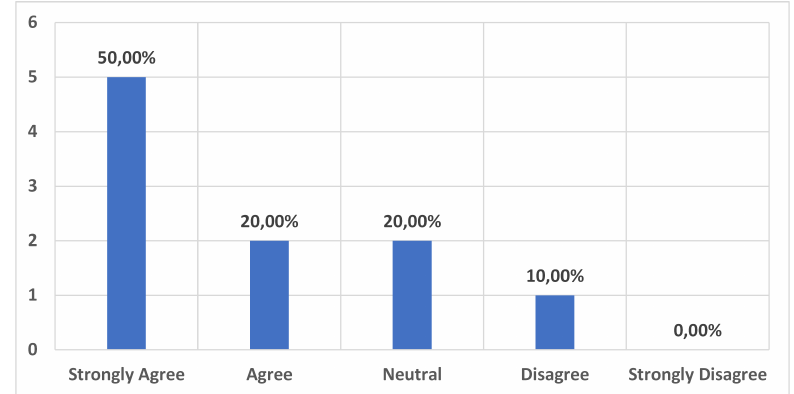
Figure 18. Functional results. A full functional Museum Guide would be a good substitution for the usual audio